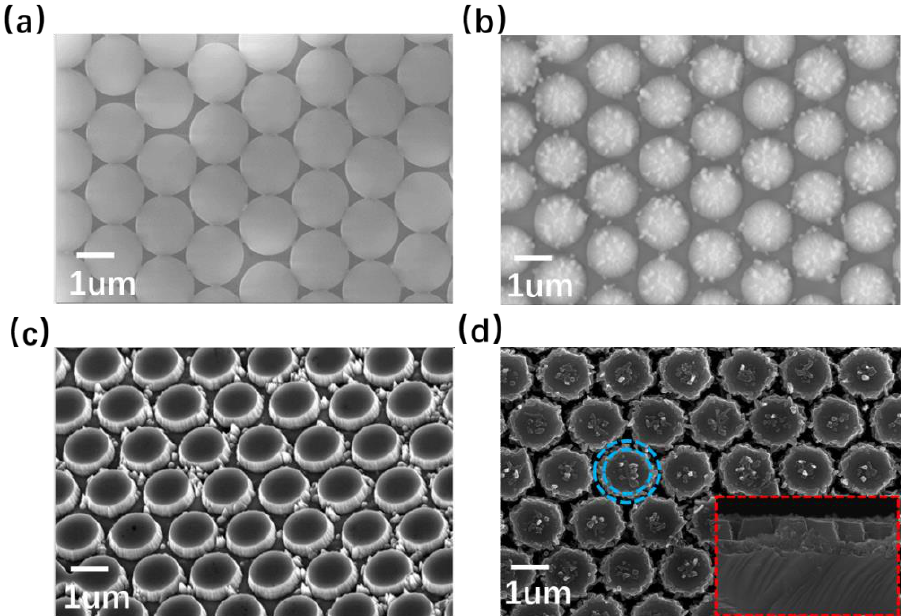
Figure 2. ( a ) Surface SEM image of microspheres. ( b ) Surface SEM image of microsphere after oxygen plasma treatment. ( c ) Surface morphology of the GaN MRAs after etching the GaN film. ( d ) Surface morphology of the oxidized Ga 2 O 3 /GaN MRAs. The inset shows the cross-sectional SEM image of Ga 2 O 3 /GaN